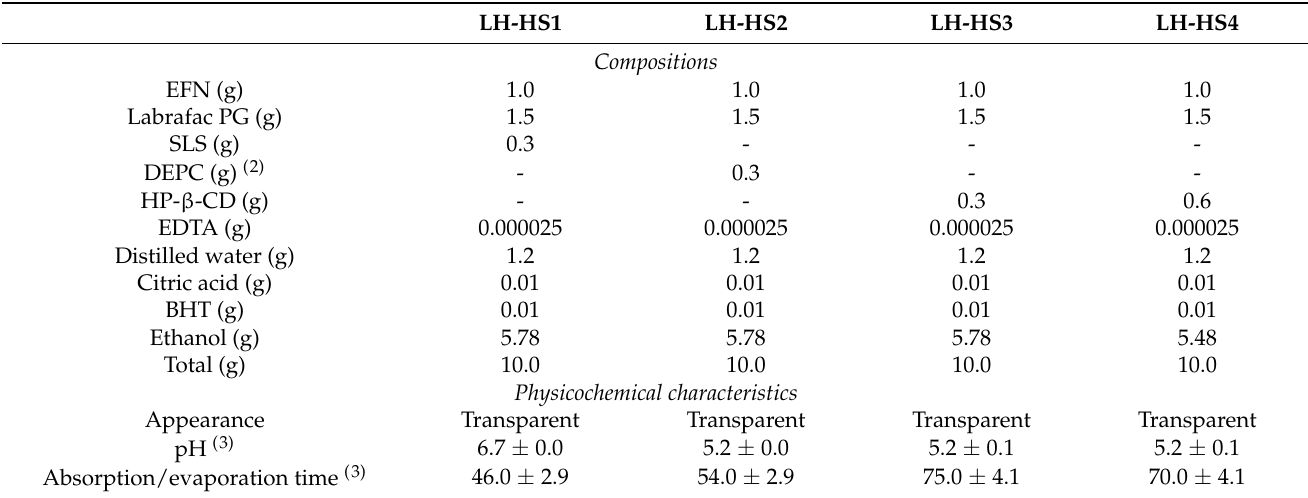
Table 2. Compositions and physicochemical characteristics of efinaconazole (EFN)-loaded hydroalcoholic solutions (HSs) with different hydrophilic permeation enhancers, along with Labrafac PG (1) as a lipophilic enhancer.